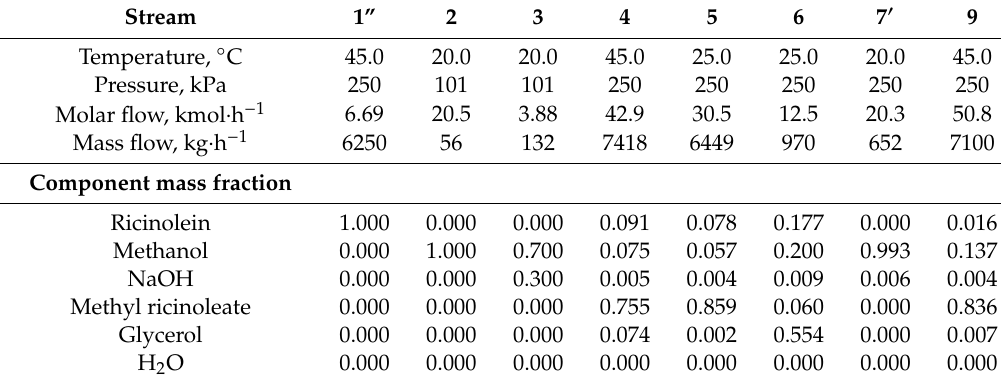
Table 6. Properties of the main streams (part